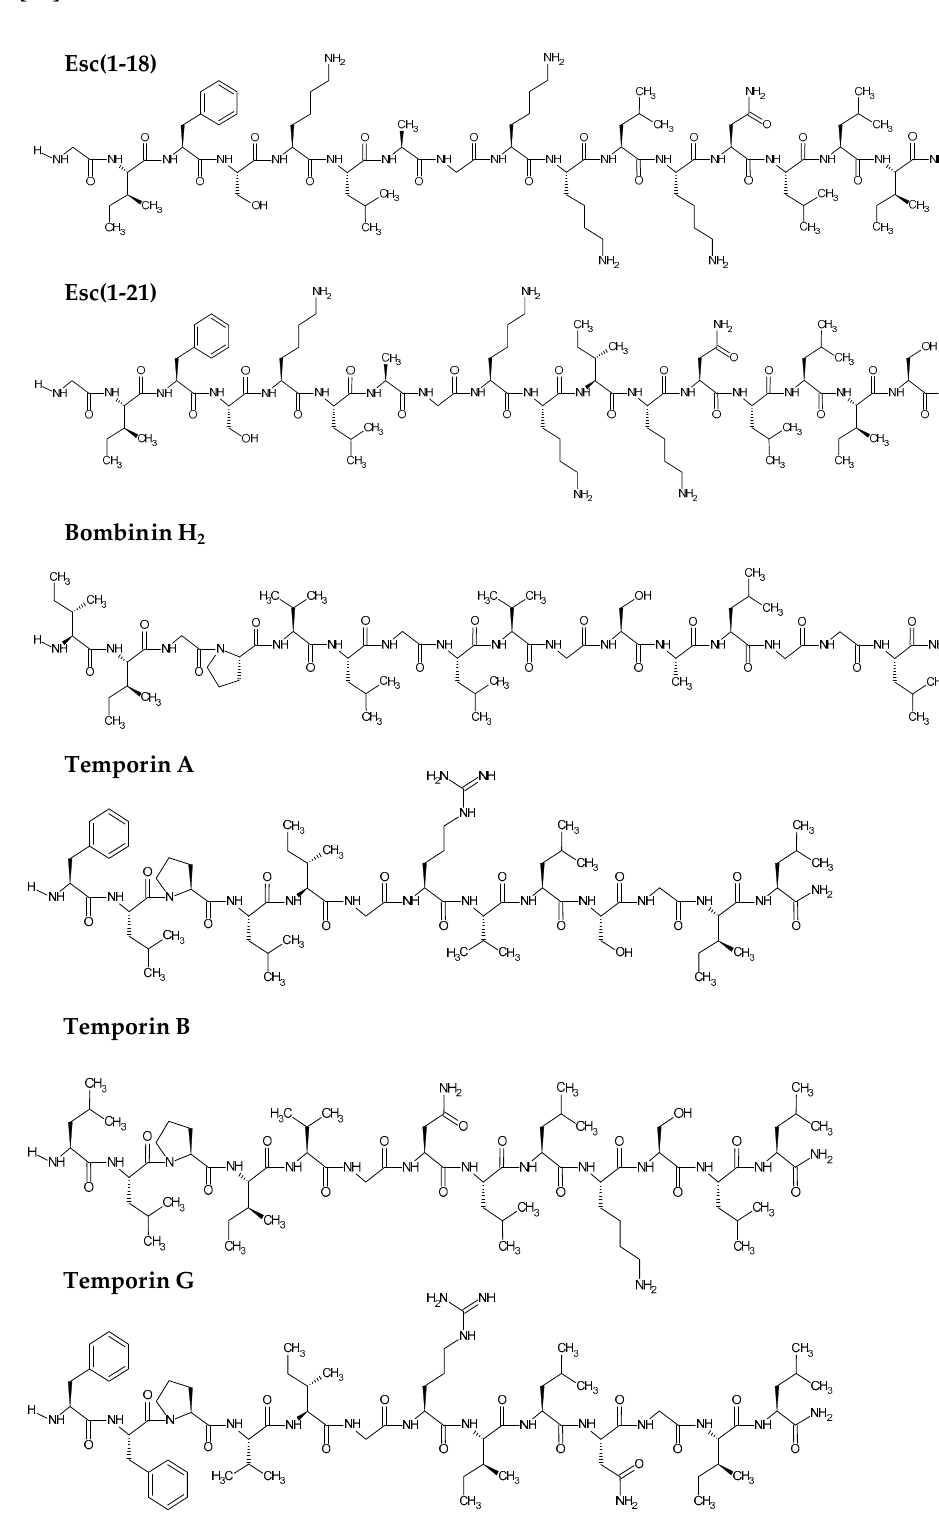
Figure 1. Names and primary structures of the selected peptides. Chemical structures were drawn with ChemSketch, Advanced Chemistry Development, Inc. (ACD/Labs).